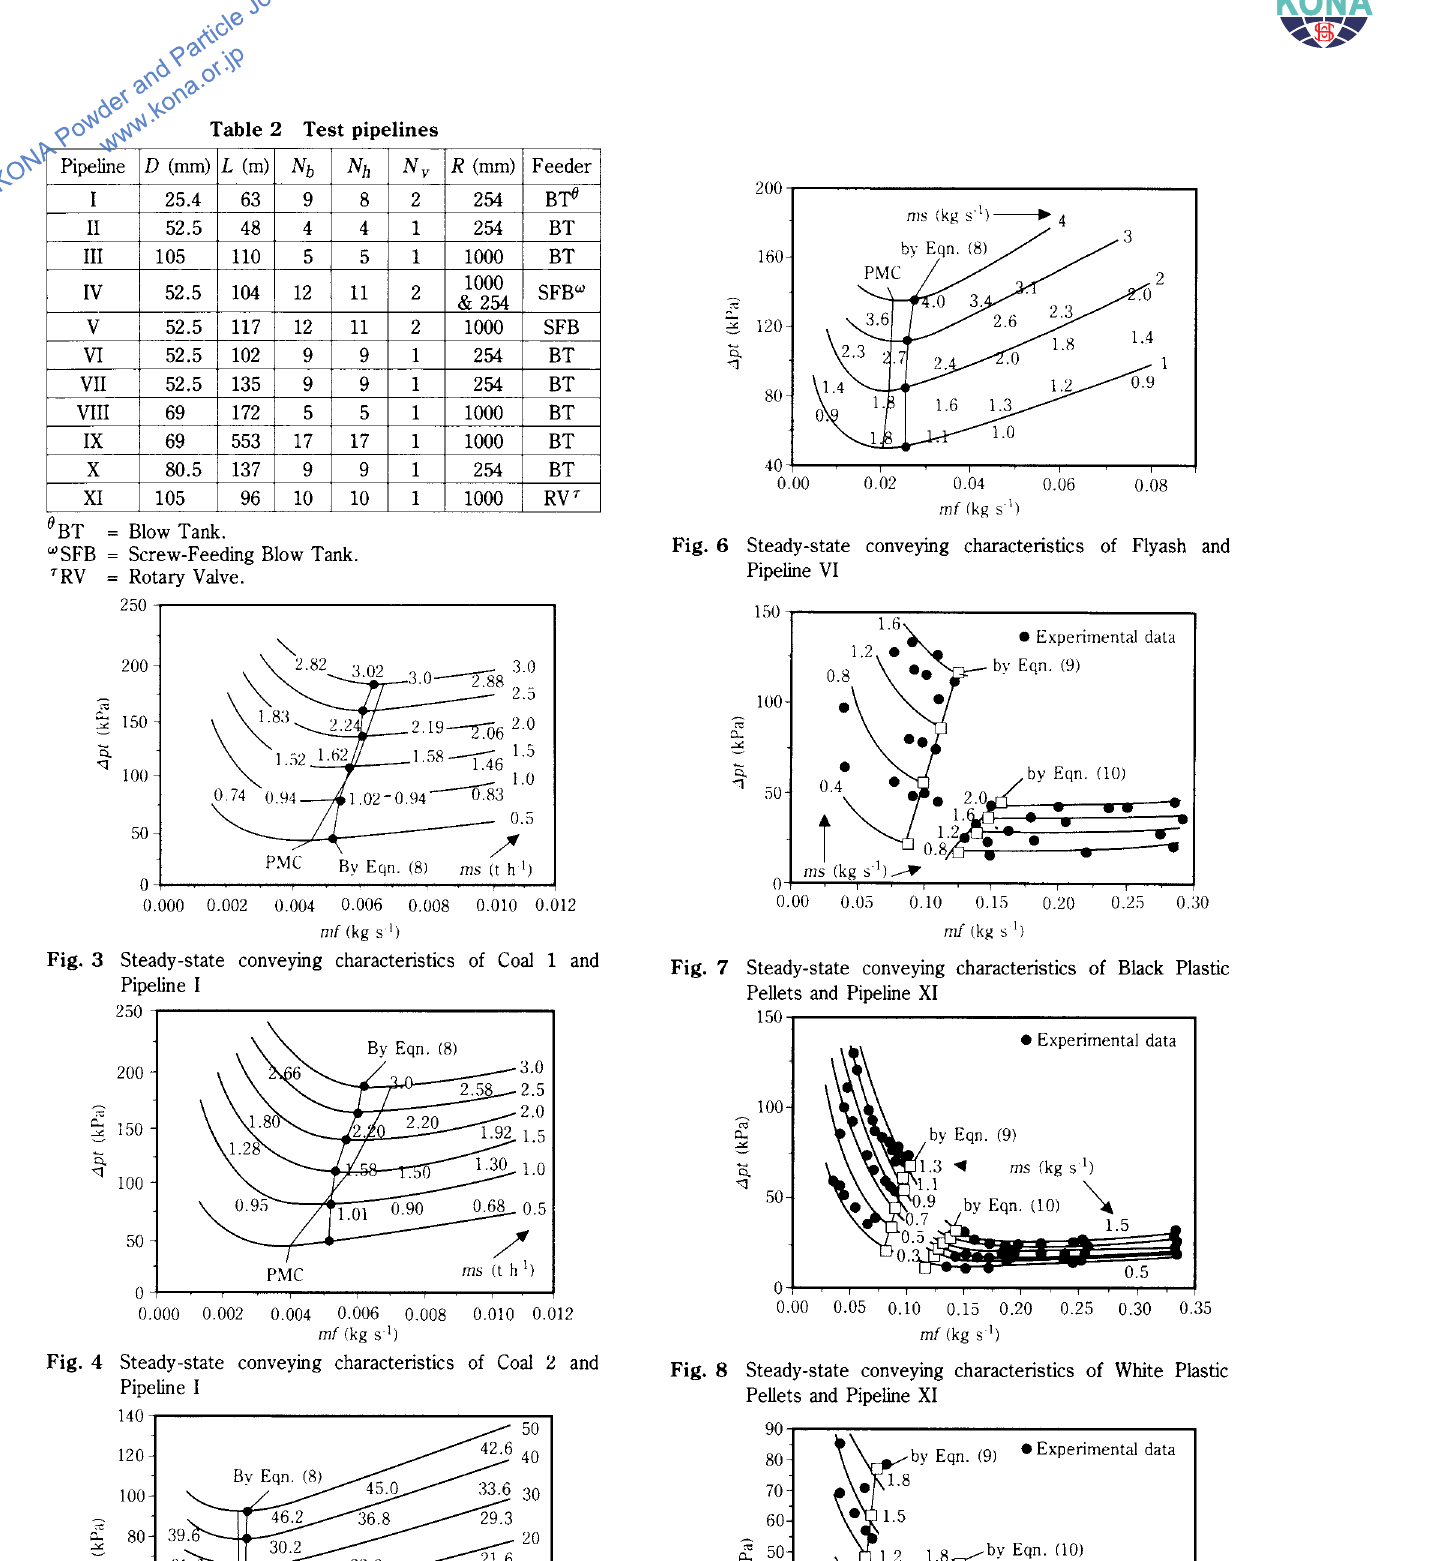
Table 2 Test pipelines